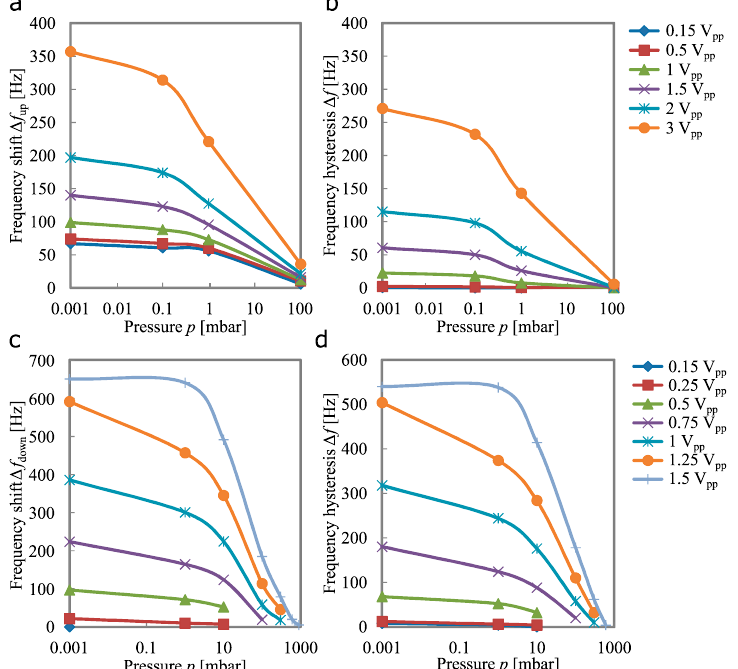
Figure 8. Frequency shift caused by the Duffing effect in dependency of the ambient pressure for the 2nd roof-tile-shaped mode of C_33 ( a ) and C_100 ( c ) for varying excitation voltages. Frequency hysteresis between the sweep directions in dependency of the ambient pressure for the 2nd roof- tile-shaped mode of C_33 ( b ), and C_100 ( d ) for varying excitation voltages. Table 3. Comparison of the key parameters for different pressure sensing